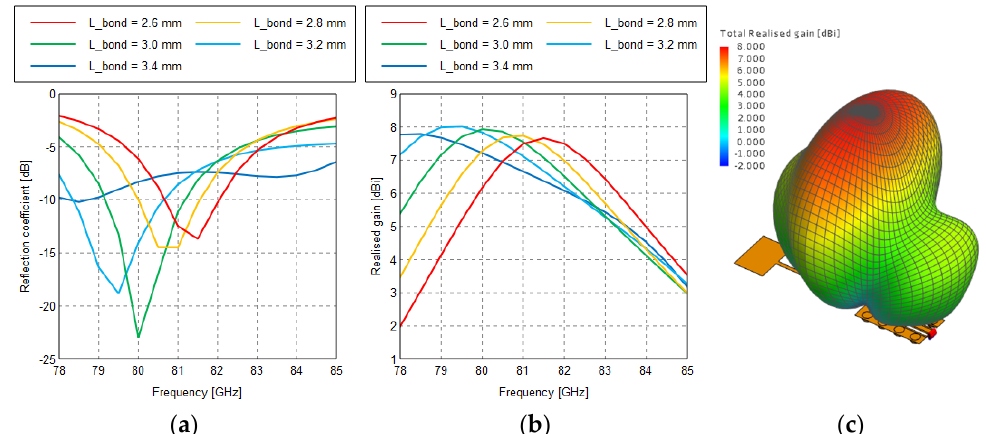
Figure 3. Simulations of the experimental design having different wire bond lengths around half- wavelength: ( a ) reflection coefficient; ( b ) realized gain (reflection loss included), broadside direc- tion; ( c ) radiation pattern at 80 GHz for the bond length of 1.6 mm.